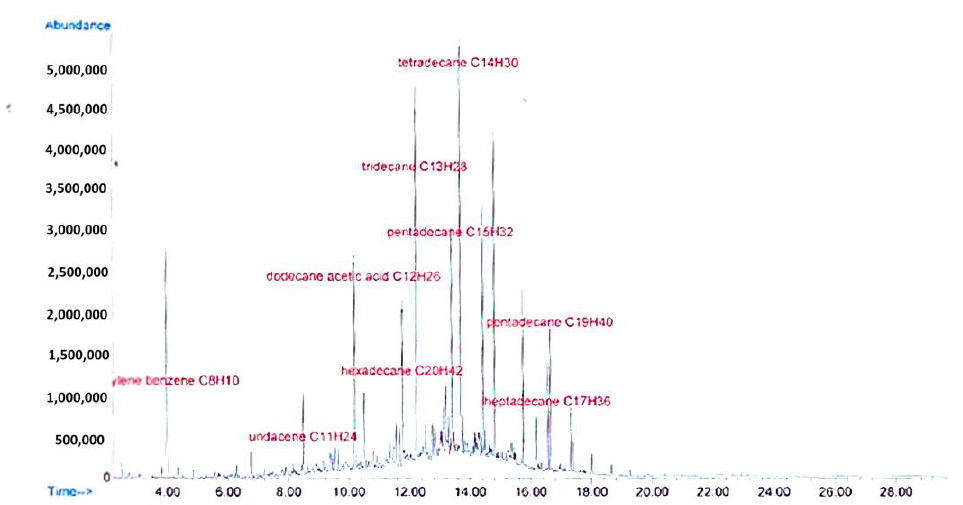
Figure 4. Natural gas liquid mass spectrometry analysis.